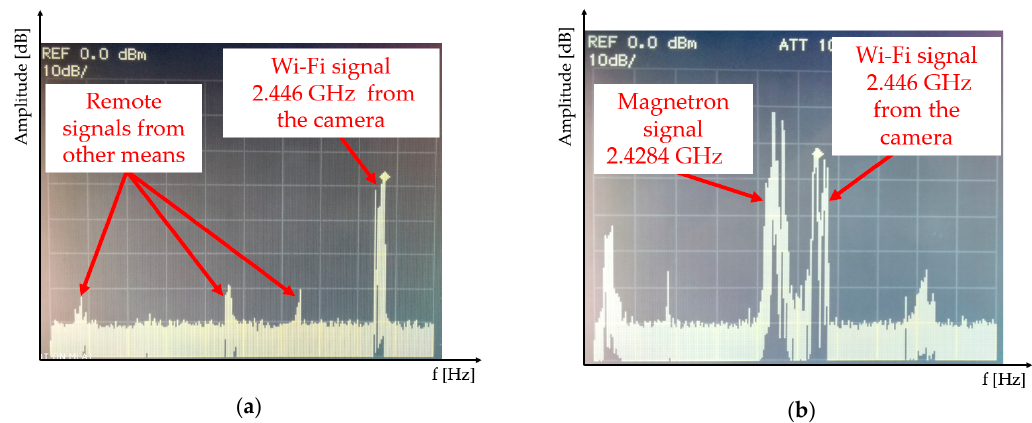
Figure 17. Wi-Fi signal capture check and disruption check in the field conditions ( a ) capturing the Wi-Fi signal; ( b ) disrupting the Wi-Fi signal using a magnetron.